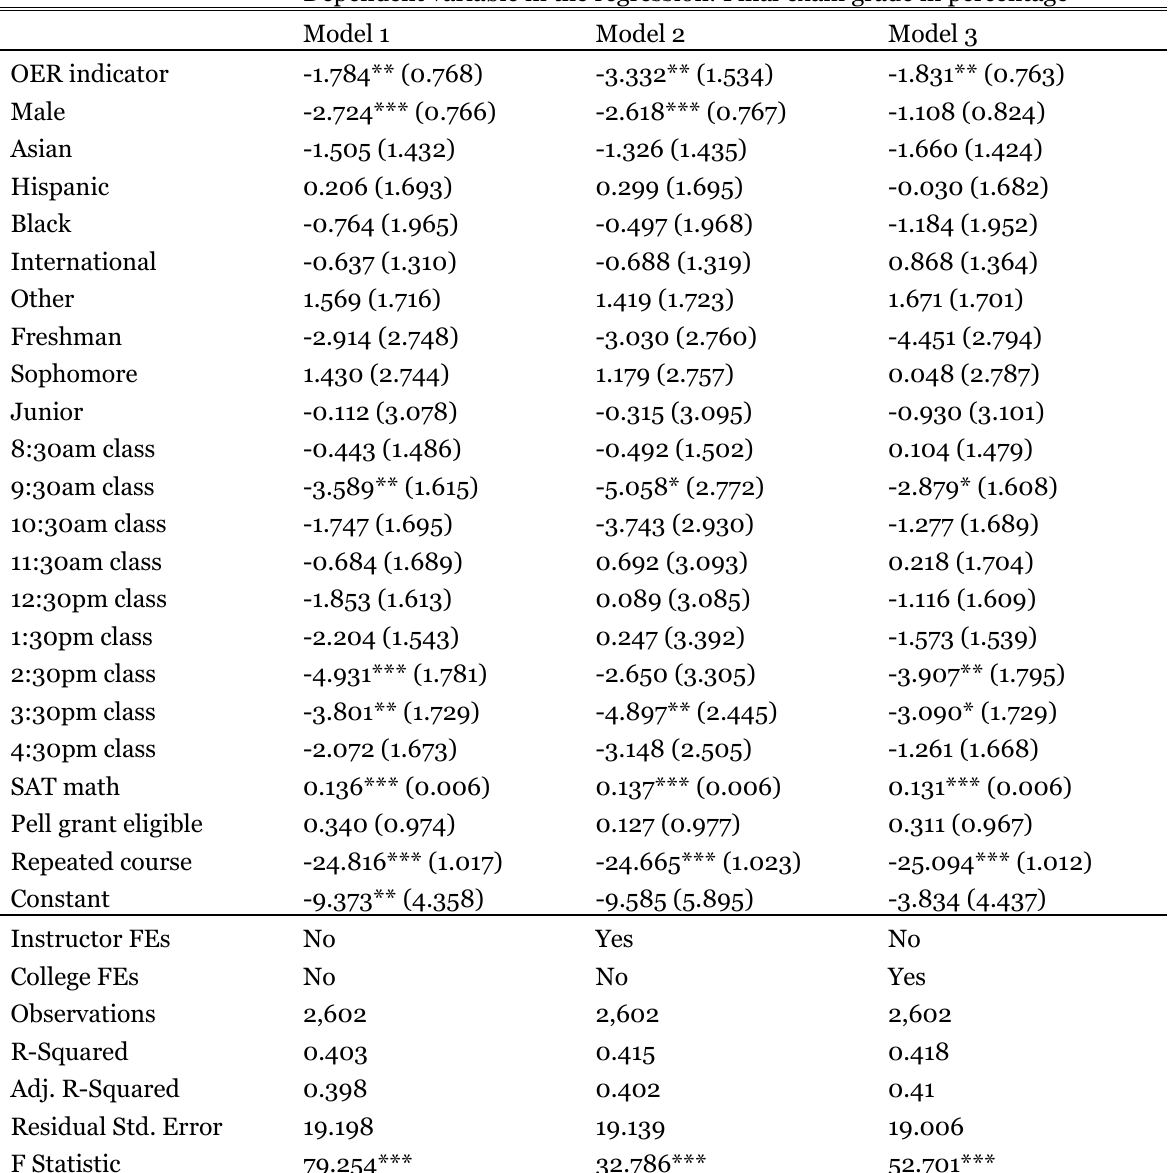
Table 5 Least Squares Regressions of the Final Exam Score of the OER Indicator and Controls Dependent variable in the regression: Final exam grade in